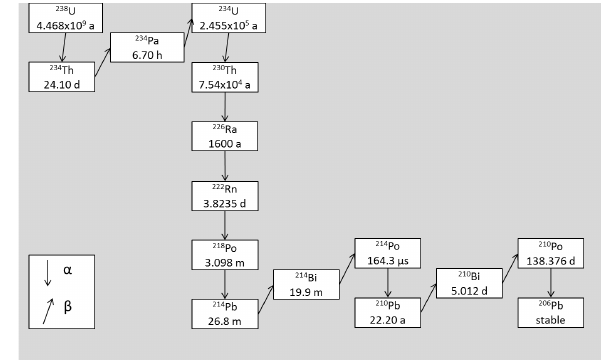
Figure 1: Primary decay chain for primordial 238 U.